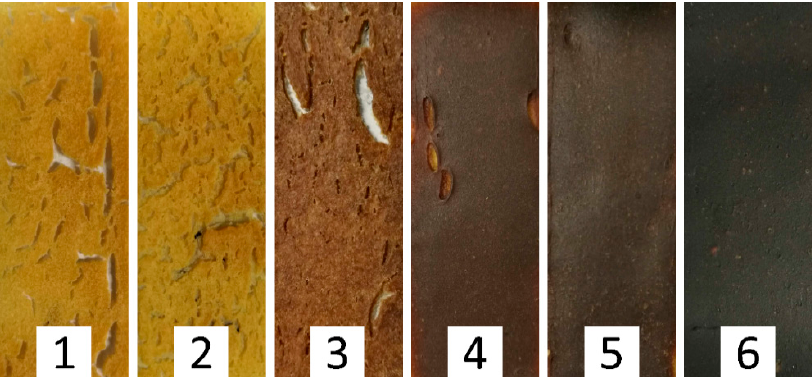
Figure 4. The toughness evaluation of the different adhesives 1: SM, 2: SM/TGIC, 3: SM/TGIC/DAS-5, 4: SM/TGIC/HD-2.5, 5: SM/TGIC/HD-5, and 6: SM/TGIC/HD-7.5.